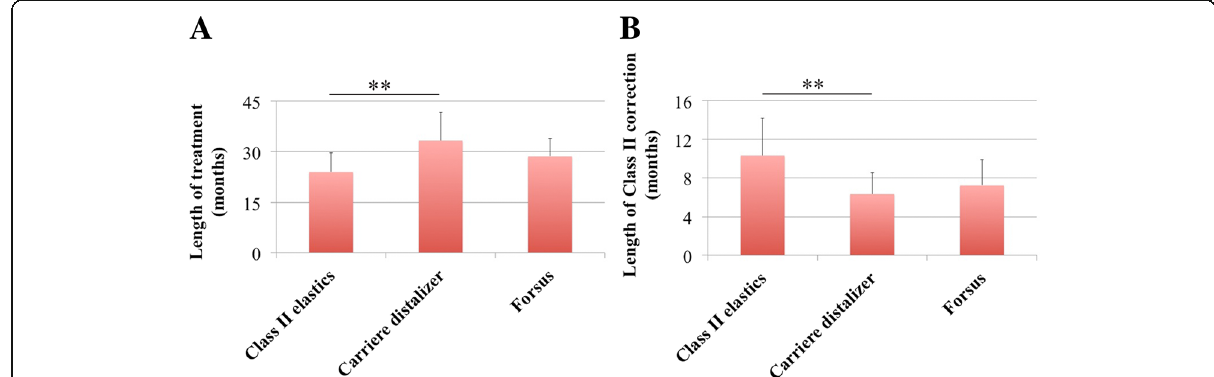
Fig. 3 a , b Length of treatment (total treatment time) and length of Class II correction (time for elastics/appliance use). * P <0.05, ** P <0.01, *** P